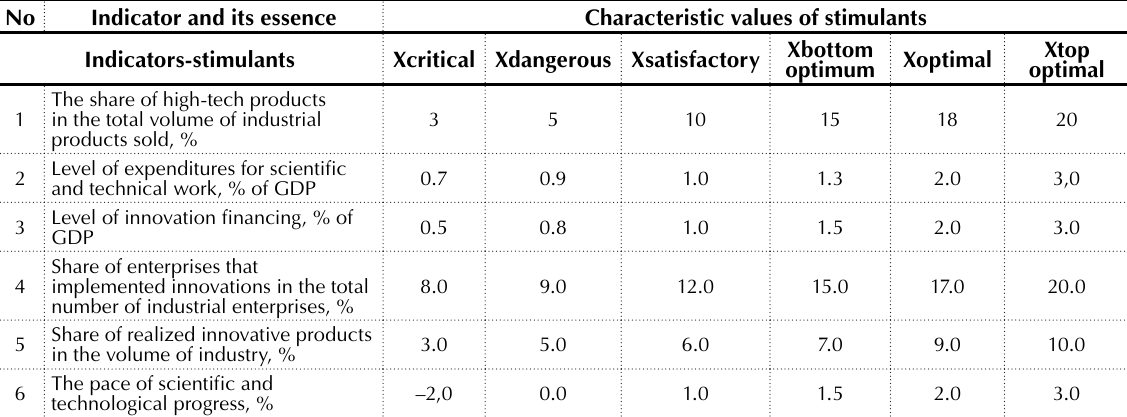
Table 1. Characteristics of component indicators of innovation